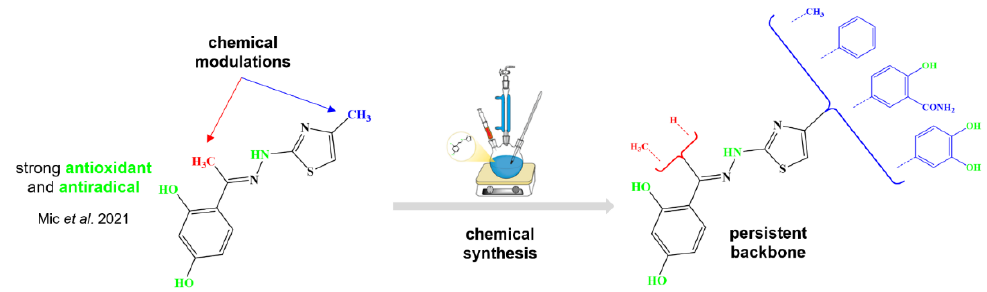
Figure 1. The hypothesis for the design of this research study.